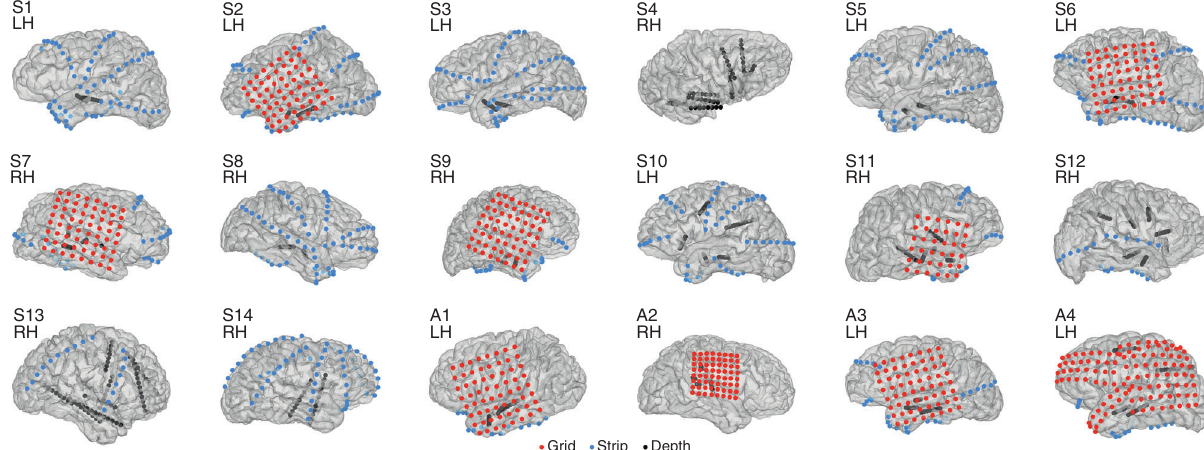
Fig. 1 Electrode coverage for 18 patients who underwent invasive monitoring for epilepsy surgery and received either tACS or acoustic stimulation. Thirteen patients had tACS applied at a 1 or 0.75 Hz frequency, at stimulation intensities ranging from 0.5 to 2 mA, during waking rest (S1 – S6) and daytime NREM sleep (S7 – S13), one patient had trapezoidal tACS (S14), and four subjects received 0.75 and 1 Hz acoustic stimulation (A1 – A4). Electrode placement varied by clinical indication, and consisted of a combination of strips, grids, and depth electrodes. Seven subjects had bilateral coverage (S1, S2, S3, S6, S8, S10, S13, S14). A total of 2156 electrodes total were utilized (1700 tACS; 113 Trapezoidal tACS; 343 acoustic), or an average of 120 electrodes per subject. Further demographic and clinical characteristics, electrode coverage, and stimulation protocols are summarized in Supplementary Table